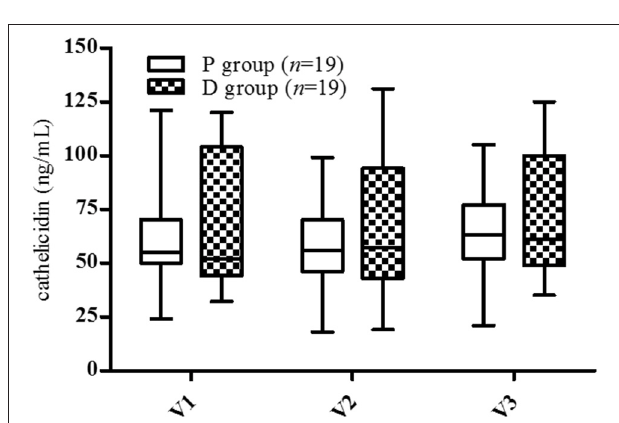
FIGURE 3 | Cathelicidin serum levels. V1, inclusion; V2, end of supplementation and vaccination; V3, 28 days post-vaccination. Data are expressed as mean ± SD. No statistical difference was observed by two-way ANOVA ( p < 0.05).